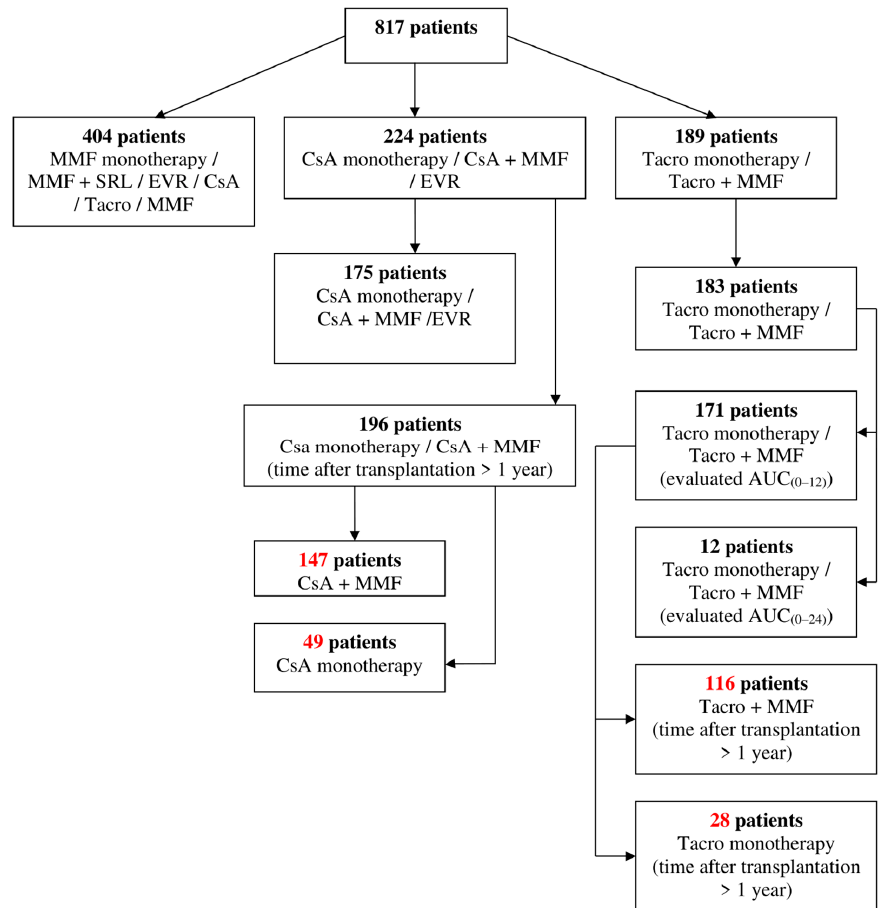
Figure 1. Patient screening. MMF, mycophenolate mofetil; SRL, sirolimus; EVR, everolimus; CsA, cyclosporine; Tacro, tacrolimus; AUC, area under the concentration time